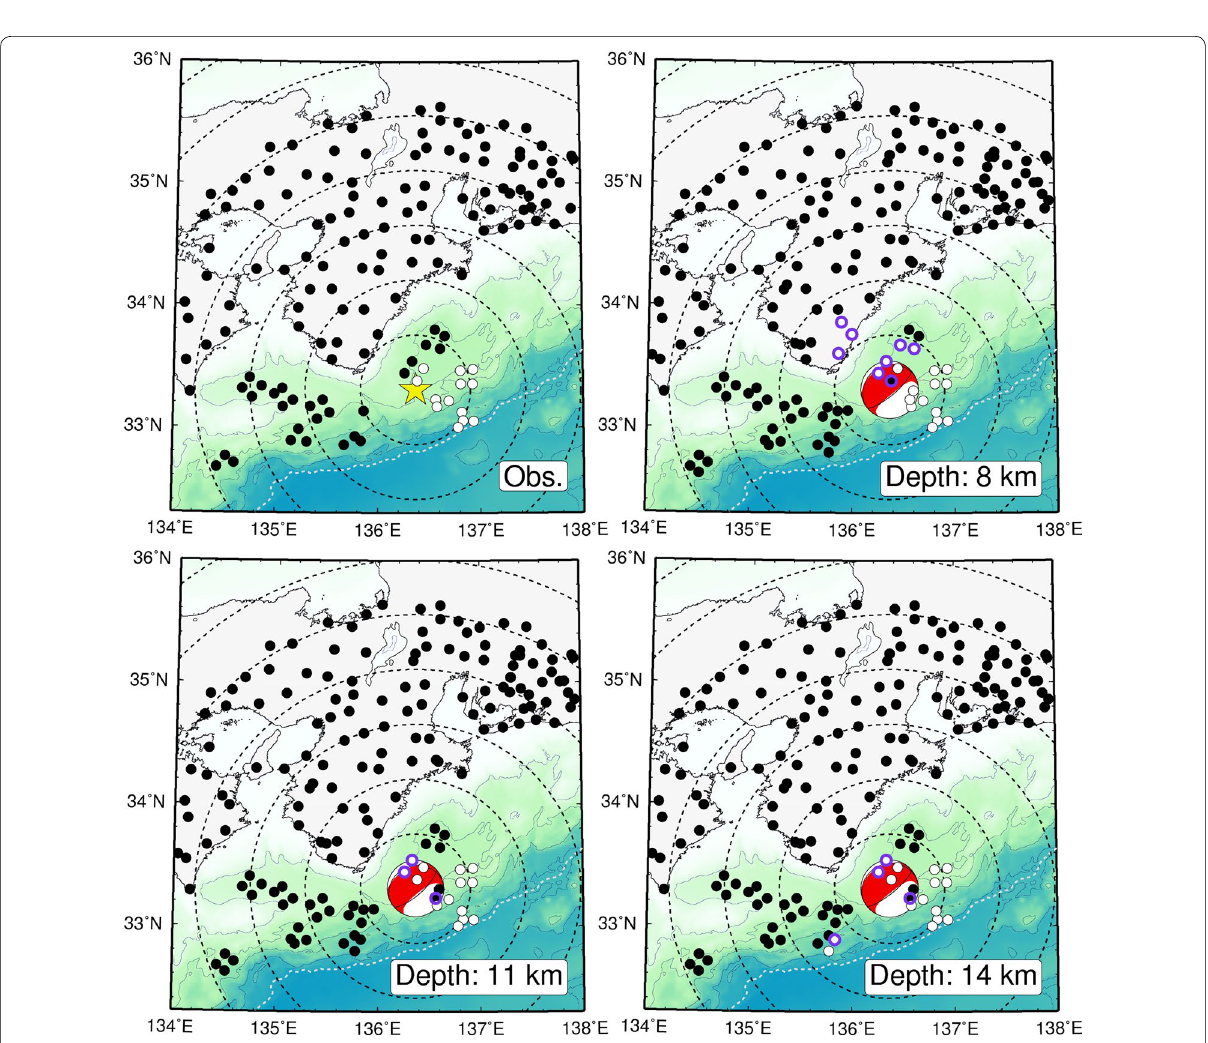
Fig. 10 Distribution of first-motion polarizations from observations and MT results. First-motion polarization is shown as black (up) and white (down) circles. Dashed lines are the isodistance lines with an interval of 50 km from the epicenter. Stations, which show different polarity compared to observations, are enhanced by purple